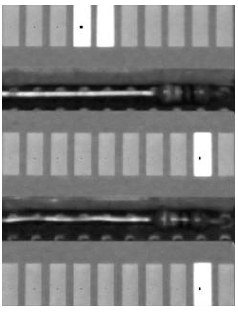
Figure 12. Thermometric image with readout